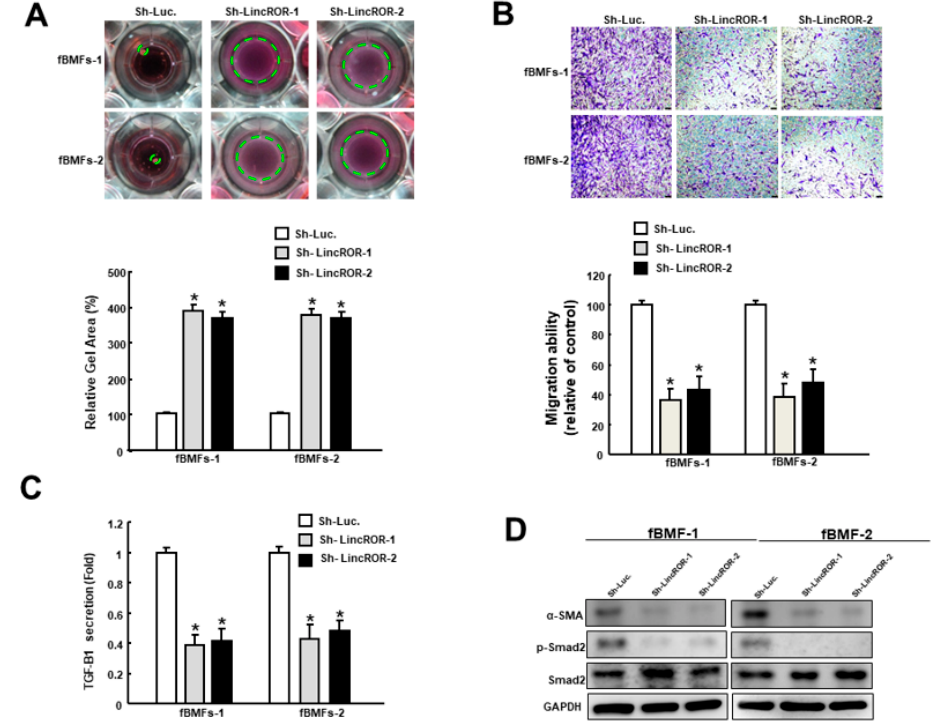
Figure 6. Silencing of LincROR downregulates myofibroblast features and fibrosis markers. Inhibition of LincROR diminished the collagen gel contraction ( A ), transwell migration ( B ), secretion of TGF- β 1 ( C ), and protein expression of α -SMA, phosphorylated Smad2 and total Smad2 ( D ). ∗ p < 0.05 compared to the control.